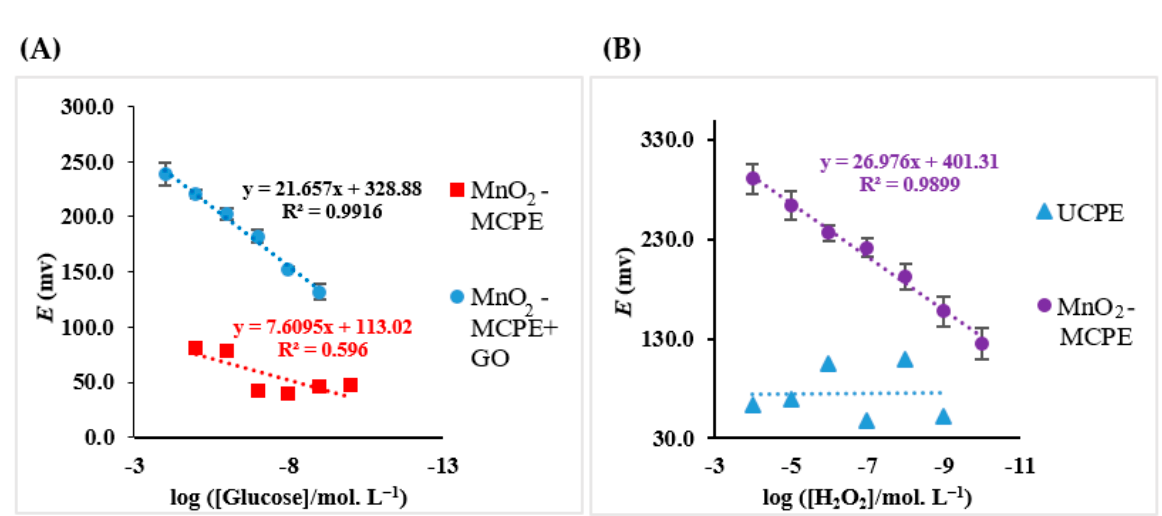
Figure 5. ( A ) Calibration curves for H 2 O 2 using different indicator electrode composition; UCPE (blue triangles) and modified CPE (71 wt % of graphite powder, 25 wt % of Nujol oil and 4 wt % of manganese dioxide) (purple circles). ( B ) Calibration curve for glucos represented in the presence (blue circle) and absence (red square) of GOx. Experimental conditions: NH 3 -NH 4 Cl buffer solution 0.10 mol·L − 1 with pH = 8.5, 6B pencil as a pseudo-reference electrode and modified CPE (71 wt % of graphite powder, 25 wt % of Nujol oil and 4 wt % of manganese dioxide) as an indicator electrode.